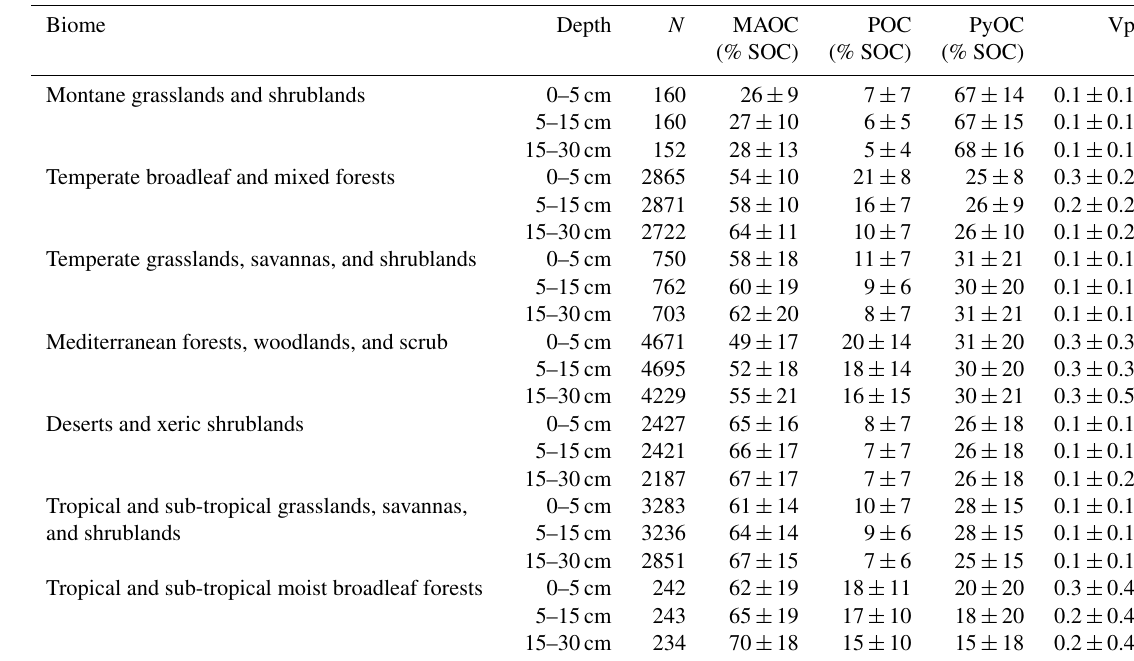
Table 2. Summary statistics, mean ( ± standard deviation) of SOC fractions, and Vp by biome. Spectral dataset used as input for digital soil mapping. N : number of observations. MAOC, POC, and PyOC.